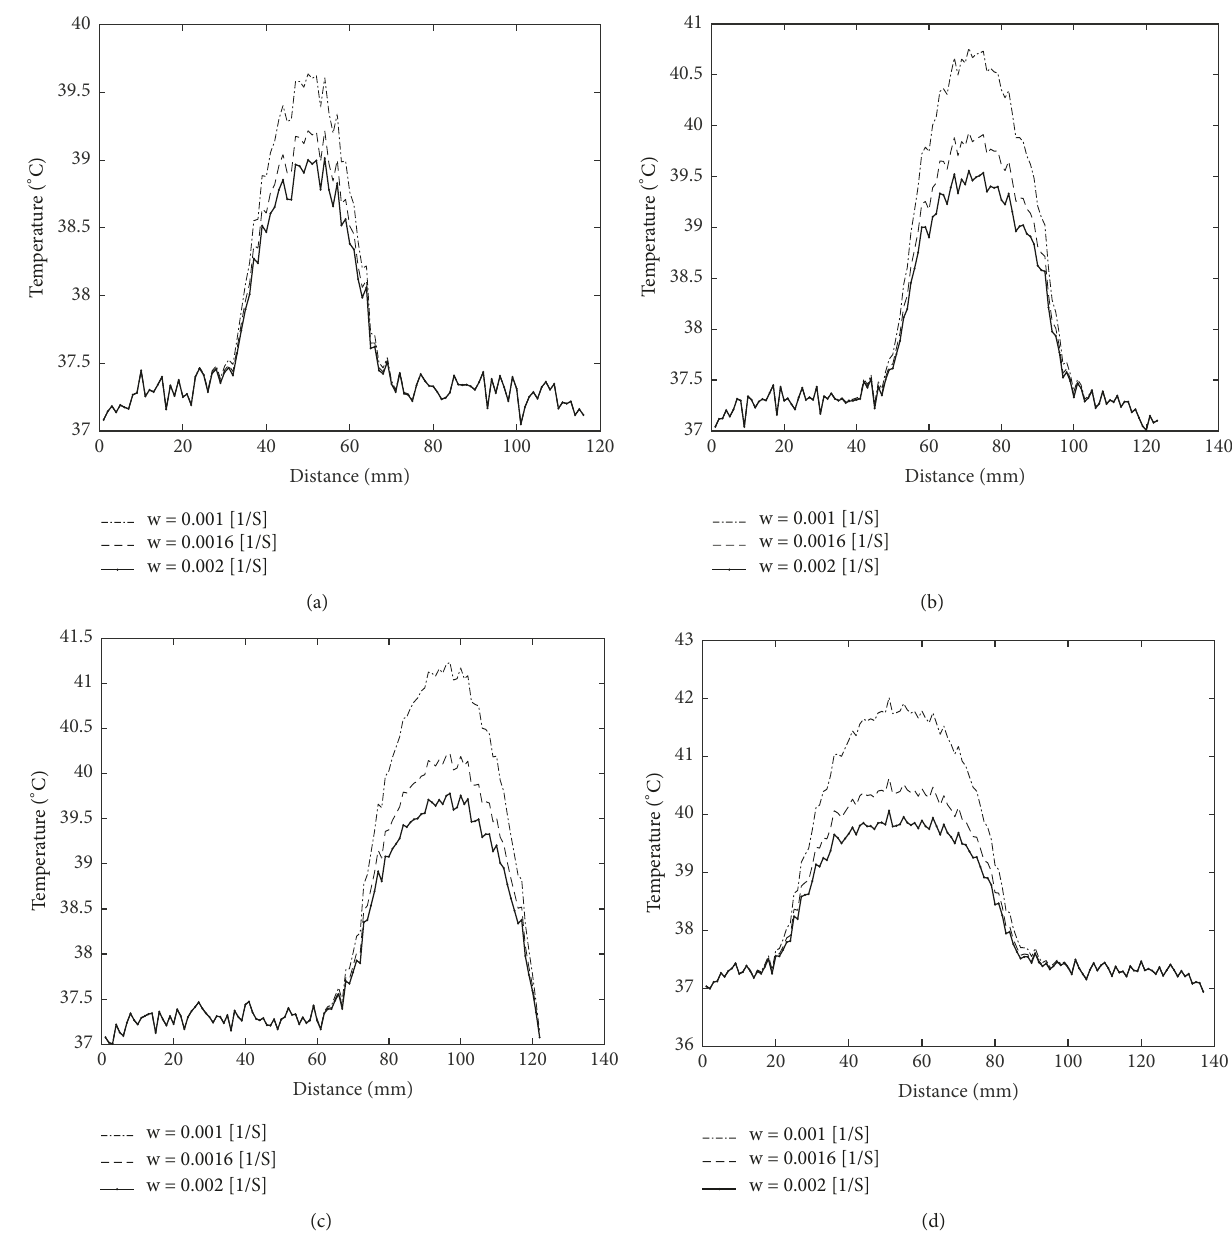
Figure 8: Temperature distribution with noise of brains with realistic tumors of different volumes by considering three values of blood perfusion rate. (a) Tumor with 11.6 cm 3 of volume. (b) Tumor with 27.4 cm 3 of volume. (c) Tumor with 51.1 cm 3 of volume. (d) Tumor with 81.7 cm 3 of